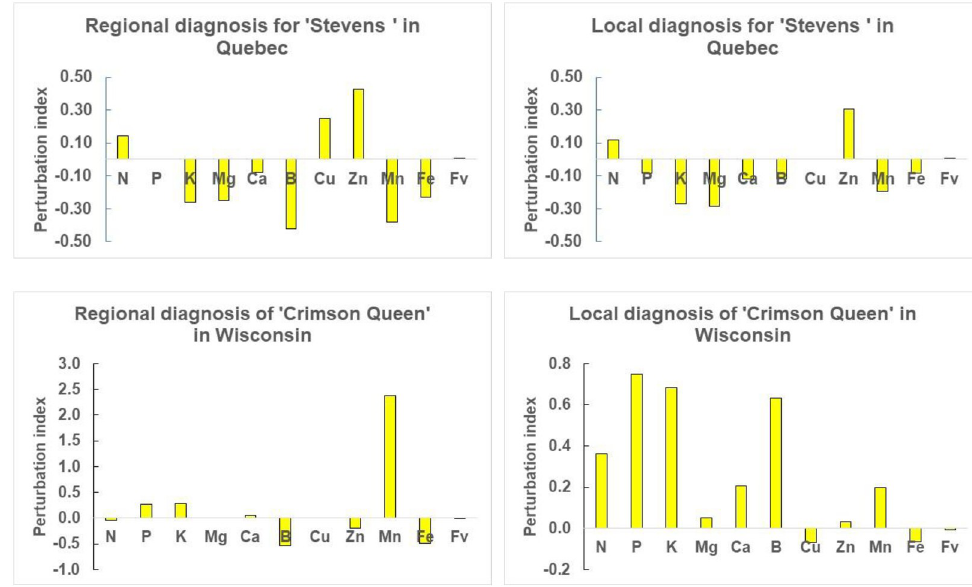
Fig 3. Nutrient diagnosis for ‘Stevens’ in Quebec and ‘Crimson Queen’ in Wisconsin at regional scale across factors or at local scale at factor-specific